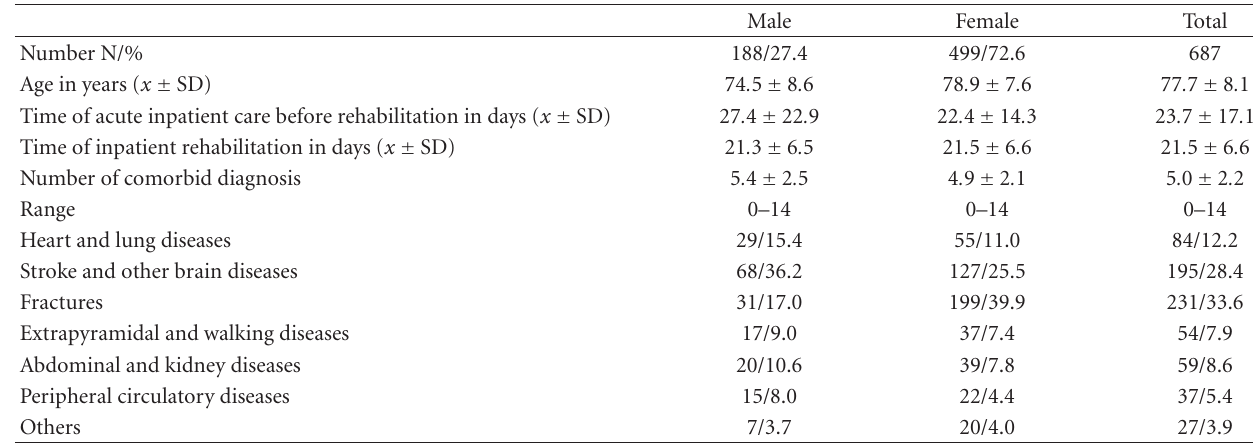
Table 1: Characteristic of the